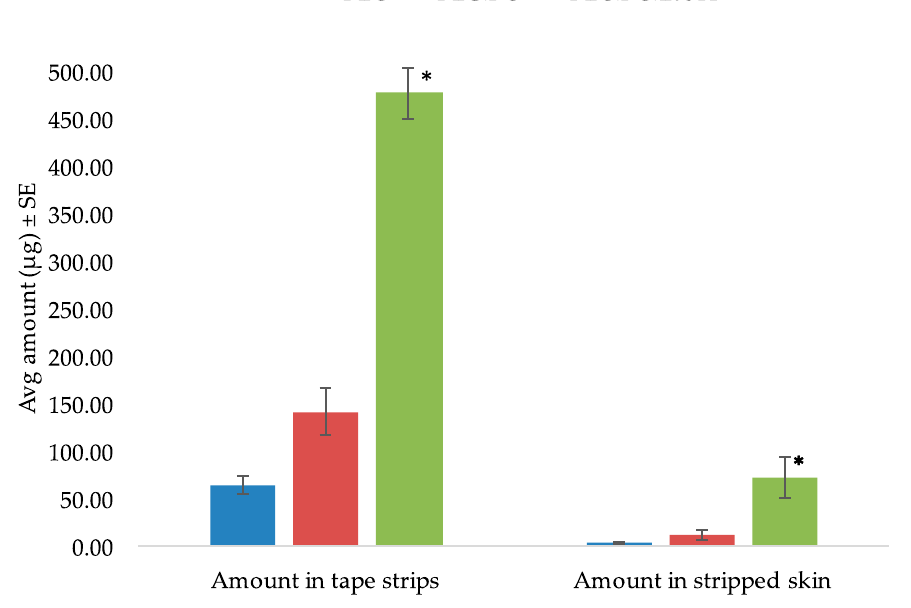
Figure 2. Amount of SN in tape strips and stripped skin using different vehicles (* indicates statistically significant compared to PEG and PEG:PG ( p < 0.05)).